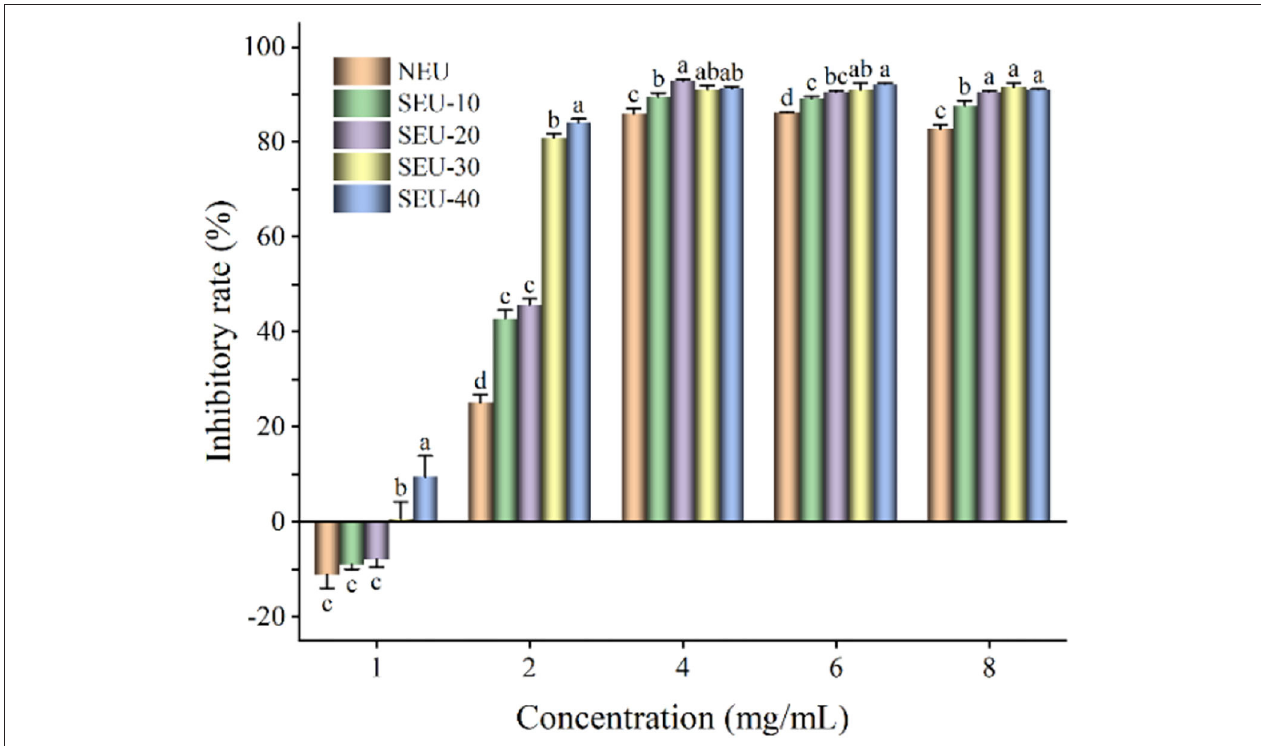
FIGURE 4 | Inhibitory rate of Eucommia ulmoides Oliver bark extract on CT26 cells. NEU, native Eucommia ulmoides Oliver bark; SEU, steam-exploded Eucommia ulmoides Oliver bark, SEU(10) to SEU(40) indicated steam explosion retention time was 10–40min, respectively. (Means that do not share a letter are significantly different, p < 0.05). Different letters in the same concentration indicate significant differences at p < 0.05 as determined by Duncan’s multiple range